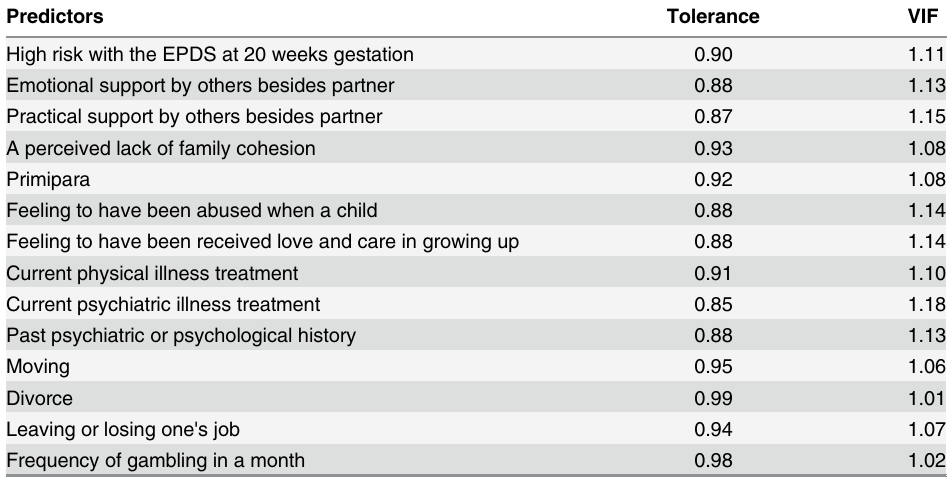
Coef fi ciency statistics means the results of the multicollinearity test in the linear regression in which the same dependent variable and independent variables of the logistic regression analysis were used. Tolerance and VIF means tolerance value and variance in fl ation factor in the multicollinearity test,